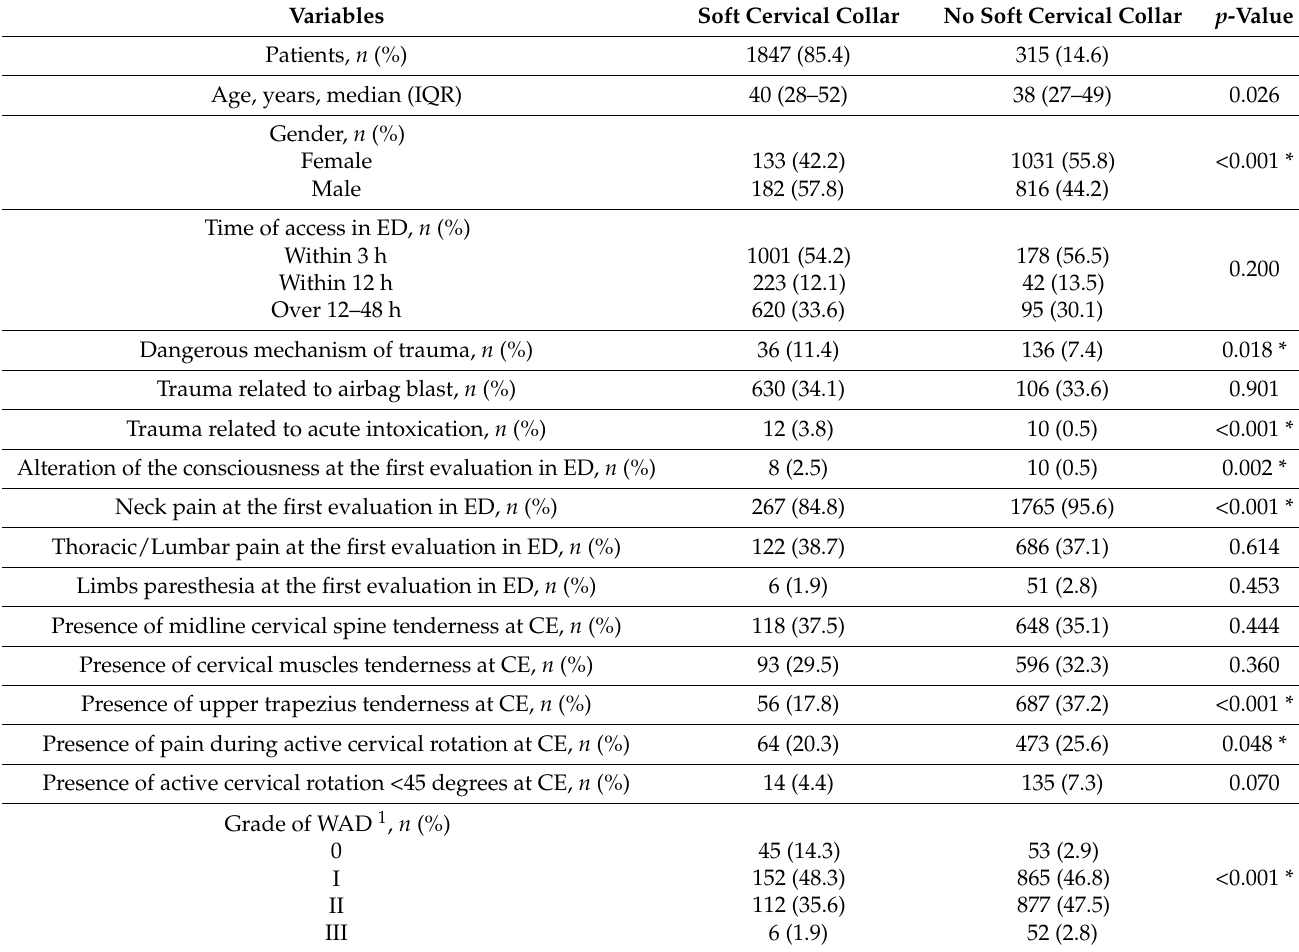
Table 2. Baseline characteristics and clinical